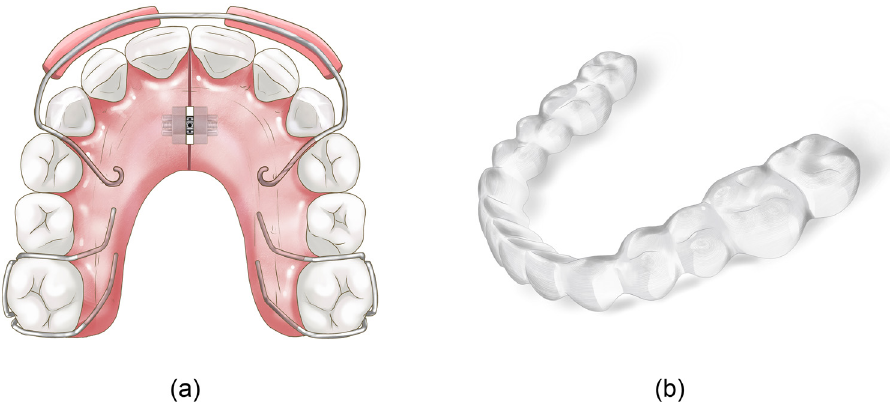
Figure 3: ( a ) Traditional removable orthodontic appliances and ( b ) clear